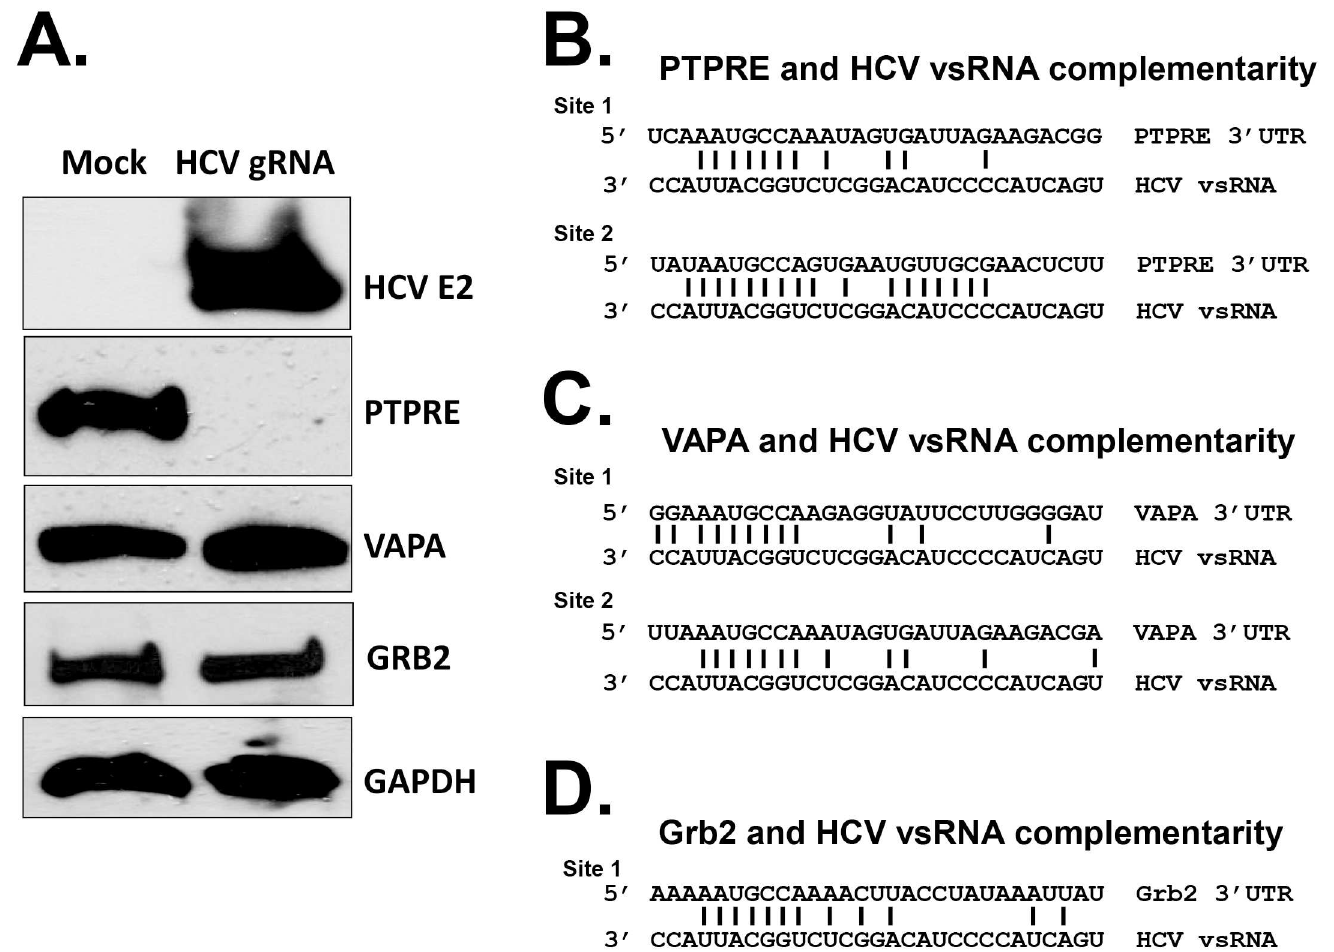
Fig 3. Hepatitis C virus genomic RNA selectively inhibits PTPRE expression. Huh 7.5 cells weremock transfectedor transfectedwith full-length, in vitro transcribedHCV genomicRNA (gRNA)(A). HCV E2, PTPRE, VAPA and Grb2 proteinlevelswereanalyzed96 hours later by immunoblot analysis (A). GAPDH servedas the loadingcontrol. PTPRE (B), VAPA (C), and Grb2 (D) have 7 to 8 nt sequences complementary to the highlyconservedHCV 8 nt sequence. Thereis 38% complementaritybetweenthe HCV RNA sequenceexaminedand VAPA, Grb2, and Site 1 of PTPRE, and 56% complementarity with Site 2 of PTPRE. PTPRE, VAPA and GAPDH expressionwere measured96 hourspost transfection by immunoblot analysis. Experiments were performedthree times with consistent results.